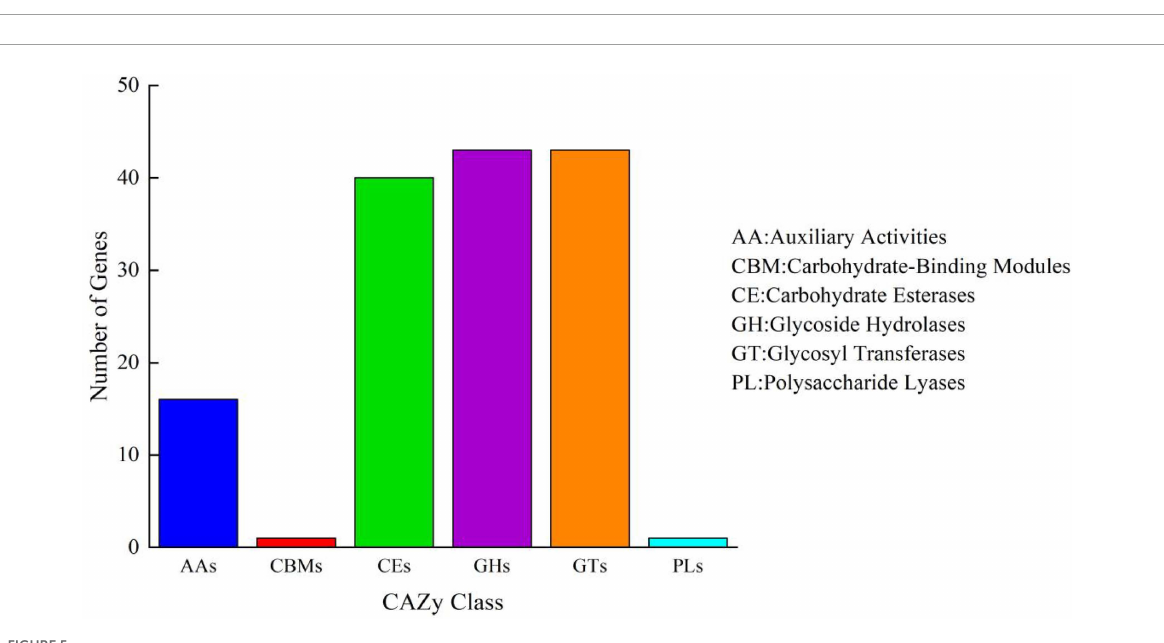
Blair et al. (2005, 2006) described five signature motifs that made up the active sites of the deacetylase domain of CE 4 family proteins. Motifs 1–5 are represented by the sequence